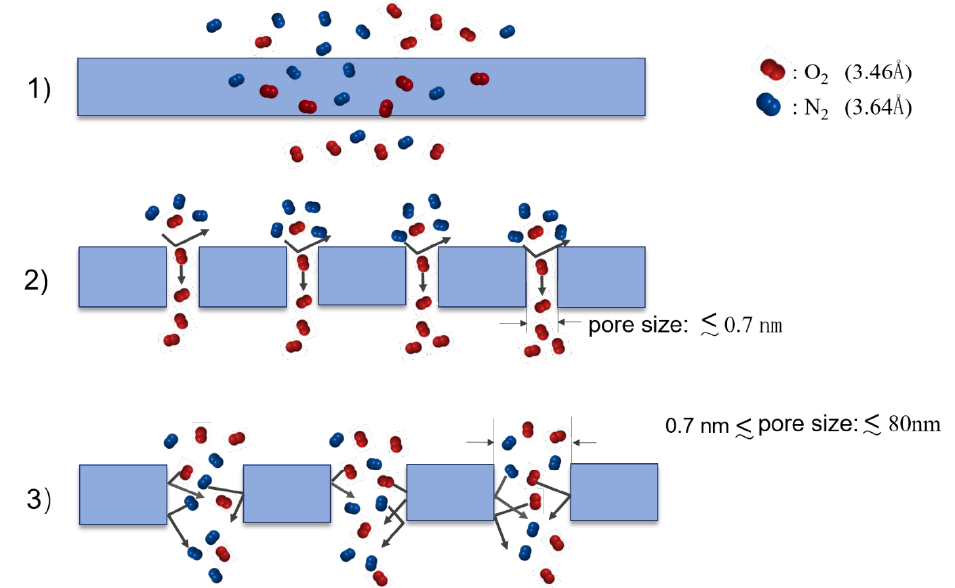
Figure 1. Mechanisms of oxygen selective permeation through membranes. (1) Solution-diffusion (SD) mechanism for dense (non-porous) membranes, (2) molecular-sieving (MS) mechanism for ultra-microporous membranes, (3) Knudsen (Kd) mechanism for microporous and mesoporous membranes.